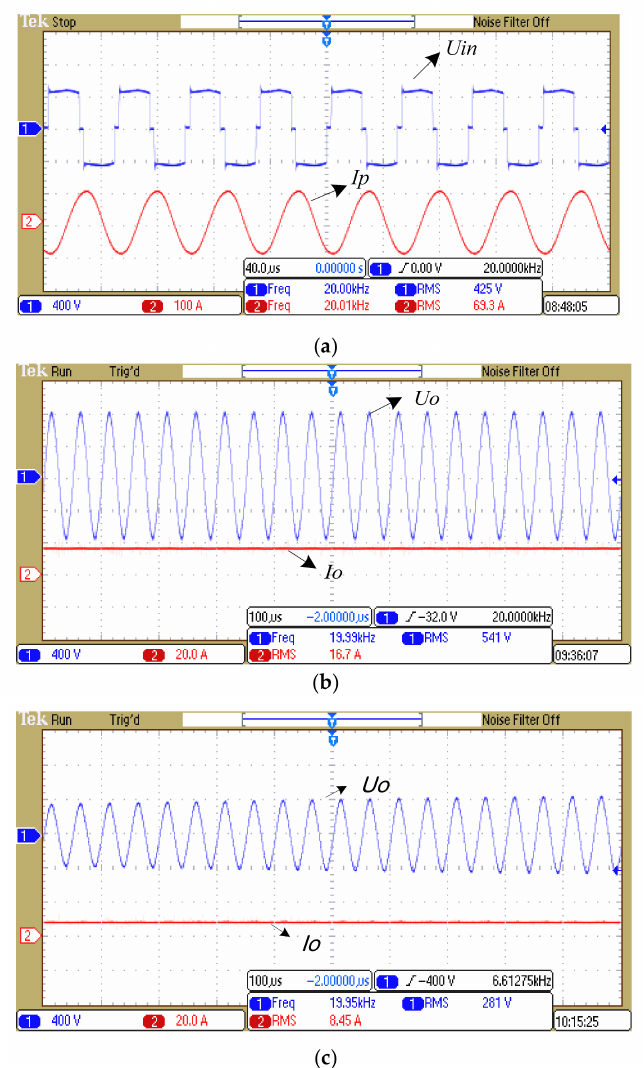
Figure 18. Experimental results of IPT system. ( a ) Waveform at the primary side (CH1:400 V/div,